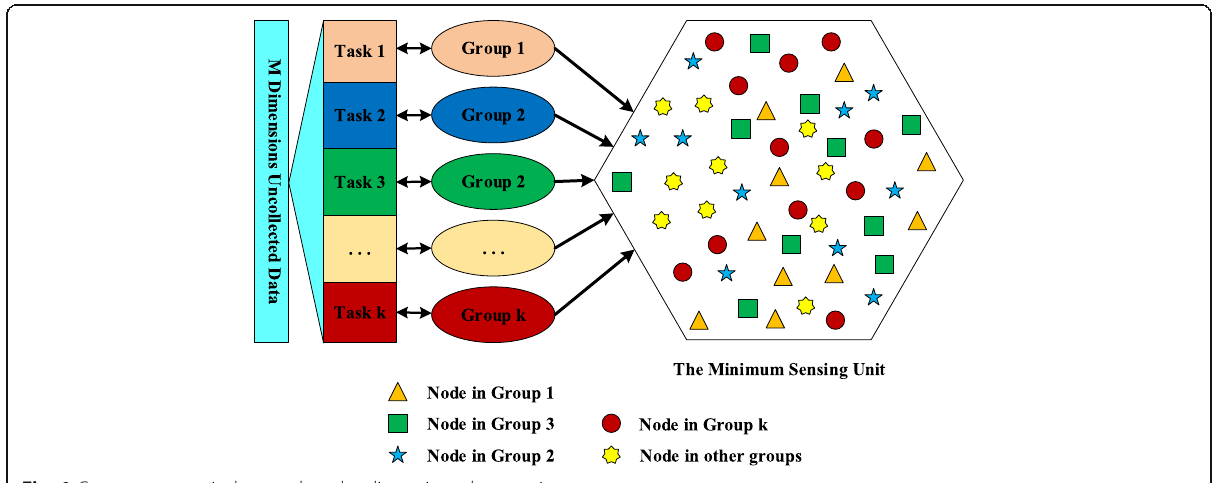
Fig. 1 Groups cooperatively complete the dimensions data